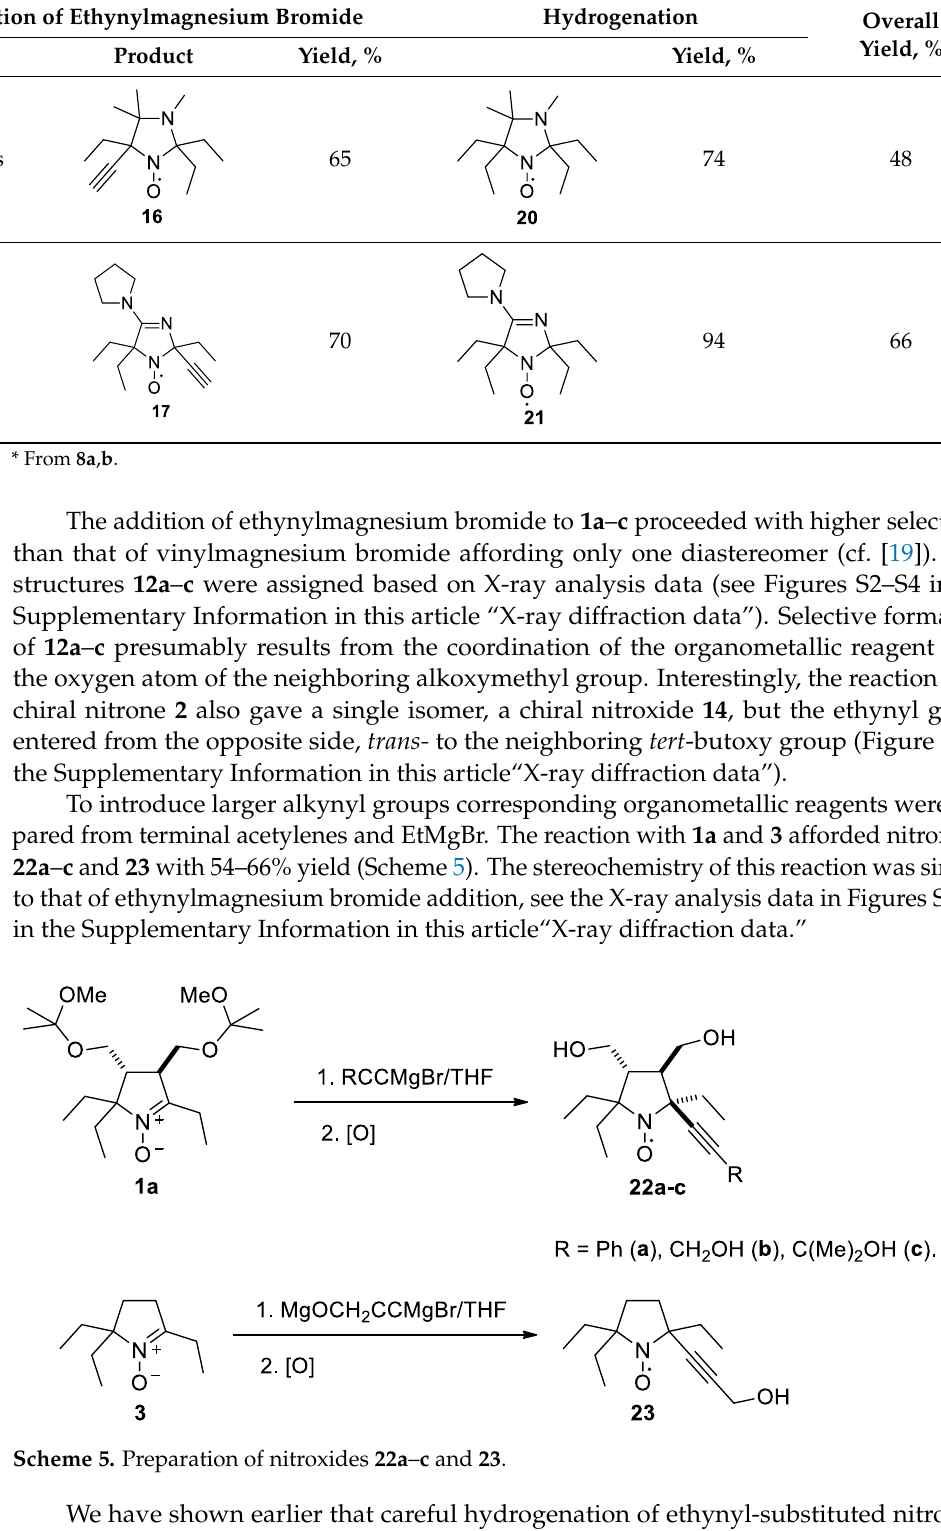
Table 2. Parameters of the EPR spectra of nitroxides in oxygen-free distilled water at a concentra-